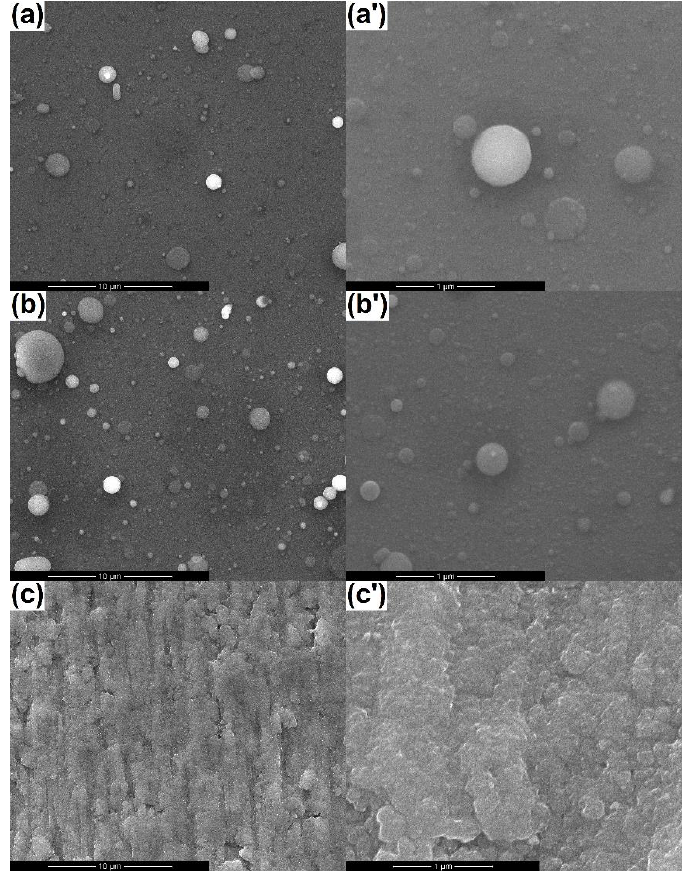
Figure 2. SEM images of the deposited thin films: ( a and a' ) PLD-RT, ( b and b') PLD-300 and ( c and c' ) SC-Ti.